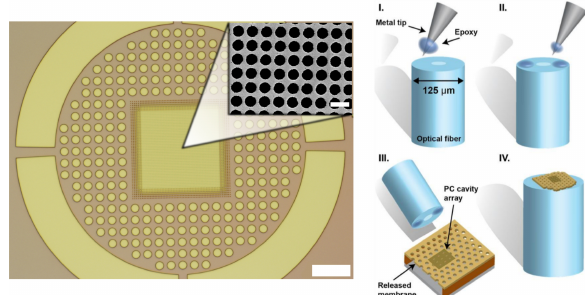
Fig. 11. (A) An optical image of the sample pattern created in the Si 3 N 4 freestanding films. The surrounding trenches are designed to allow removal of the structure from the substrate, while the inset shows a scanning electron microscope (SEM) image of the middle region containing the PC holes. The optical and SEM image scale bars correspond to 20 µm and 2 µm respectively (B) Schematics of a procedure for mounting a PC membrane onto an optical fiber tip using micro-drops of epoxy (Source: